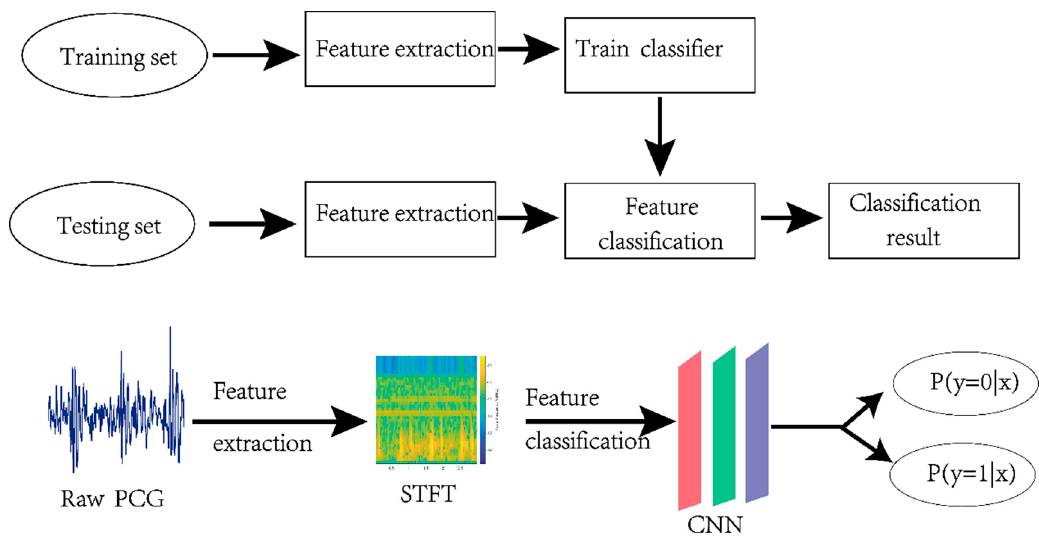
Figure 2. Block diagram of our proposed network model. Firstly, we preprocessed and segmented the heart sound data. Then, we extracted the features in the frequency domain. Finally, we sent the features to the convolutional neural network (CNN) model that we designed to classify normal and abnormal heart sounds.